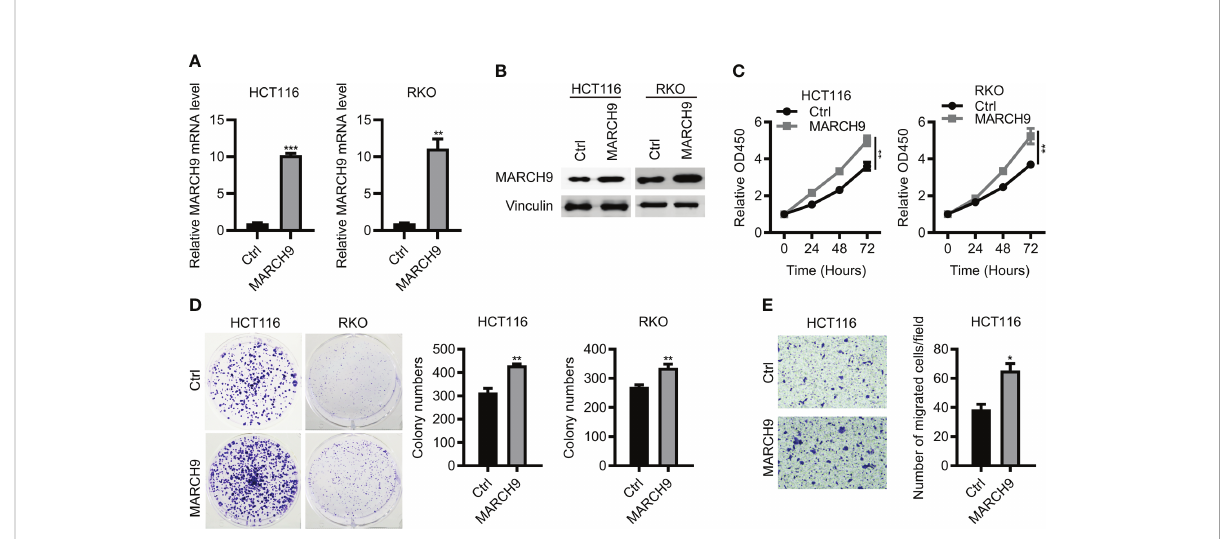
FIGURE 3 Overexpression of MARCH9 promoted CRC cell proliferation and migration. (A, B) RT-qPCR and western blot results of MARCH9 mRNA and protein levels in CRC cell lines transfected with MARCH9 or Ctrl plasmids at 48 (h) (C) CCK-8 assay results of cell viability in two CRC cell lines transfected with MARCH9 plasmids and Ctrl at 24, 48, and 72h. (D) Cell colony formation results of two CRC cell lines transfected with MARCH9 plasmids and Ctrl at 14 days. (E) The migration ability of two CRC cell lines transfected with MARCH9 plasmids and Ctrl at 48 (h) * P < 0.05; ** P < 0.01; *** P <